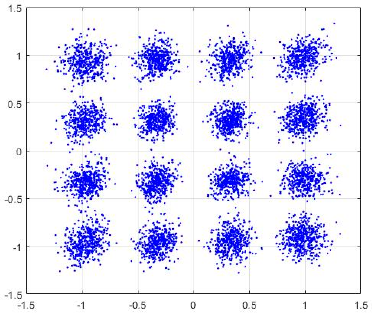
Figure 10. Measured constellation of the 245 GHz wireless communication system. Table 2. Comparison of published THz real-time wireless communication links. Ref.